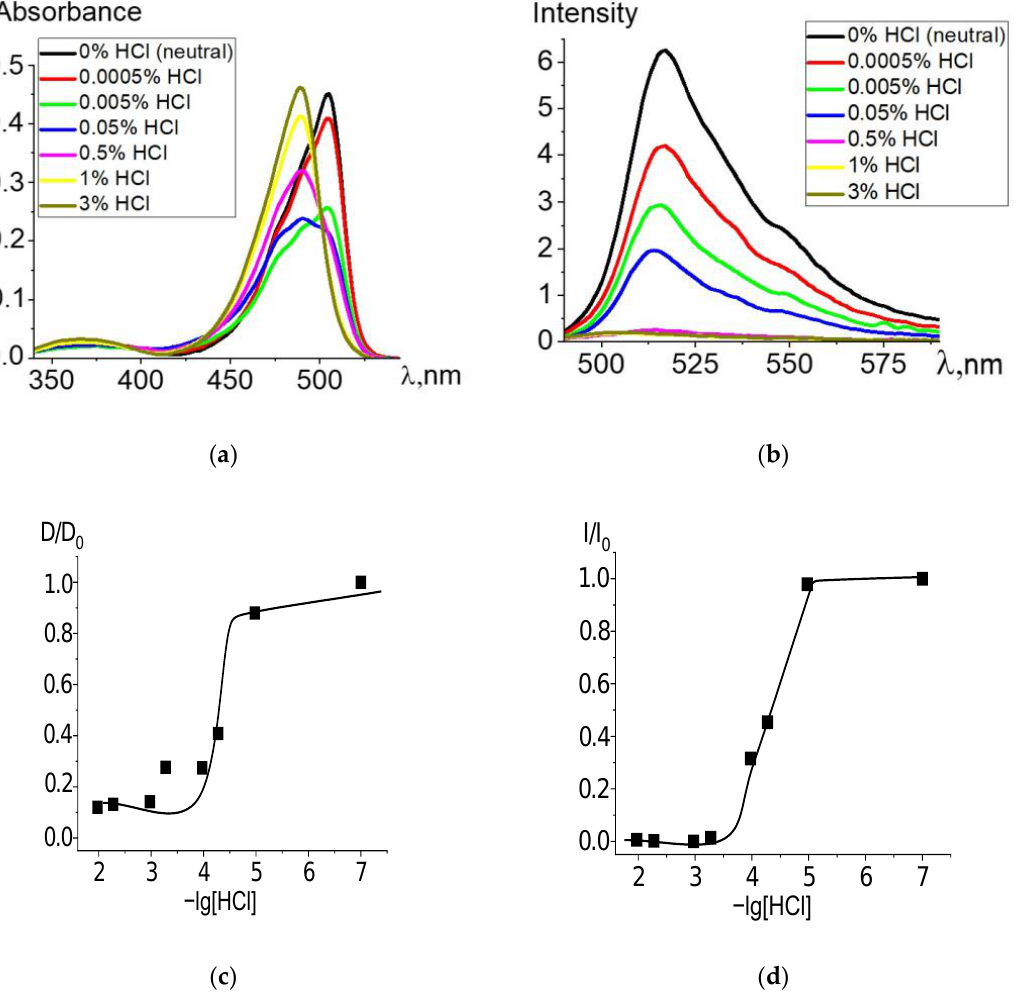
Figure 2. Changes in the absorption ( а ) and fluorescence (λ ex = 460 nm) ( b ) spectra of Zn[Br 2 (CH 3 ) 4 dpm] 2 in ethanol upon the addition of 36% (11.6 M) HCl, in varying amounts. Experi- mental titration curves for the ground state S 0 (λ = 504 nm) ( c ) and excited state S 1 (λ = 515 nm) ( d ).